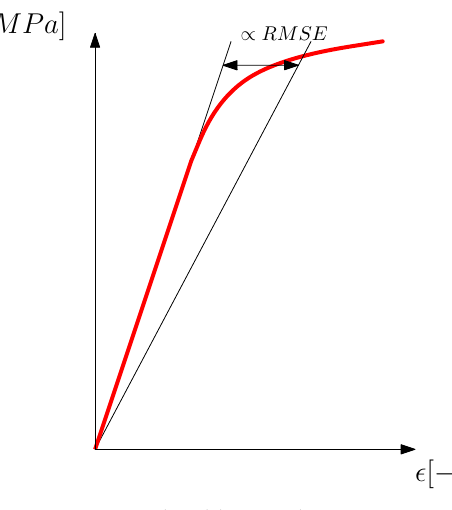
Figure 10. Actual yield stress